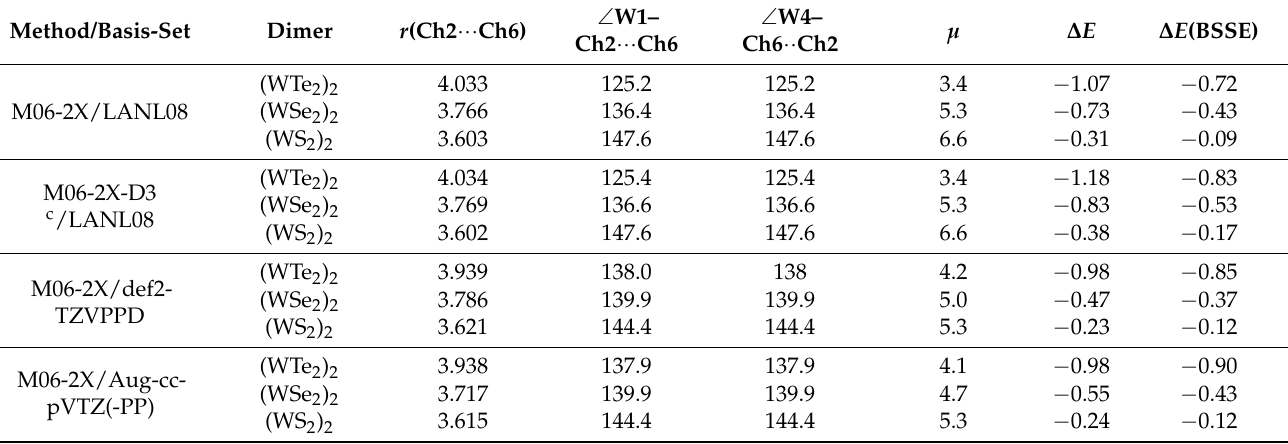
Table 1. M06-2X computed geometric, electronic, and energetic properties of (WCh 2 ) 2 (Ch = S, Se, Te) dimers, obtained with three different basis sets a,b .